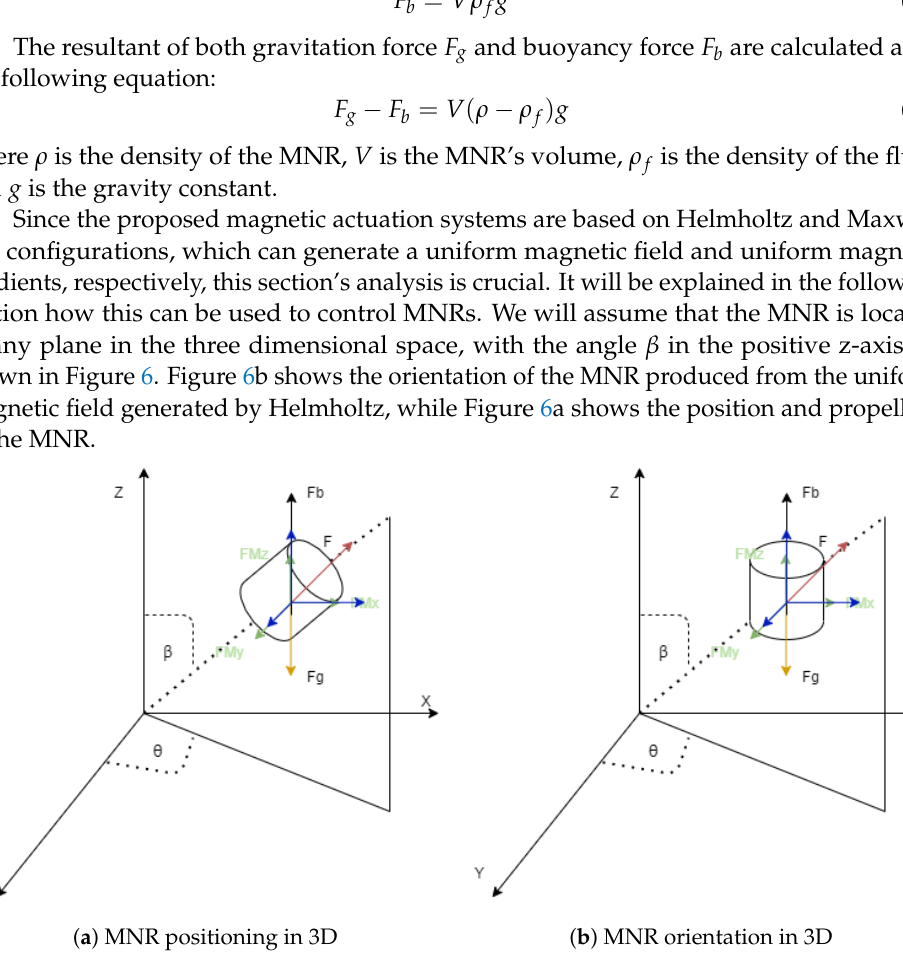
Figure 6. MNR locomotion and orientation in